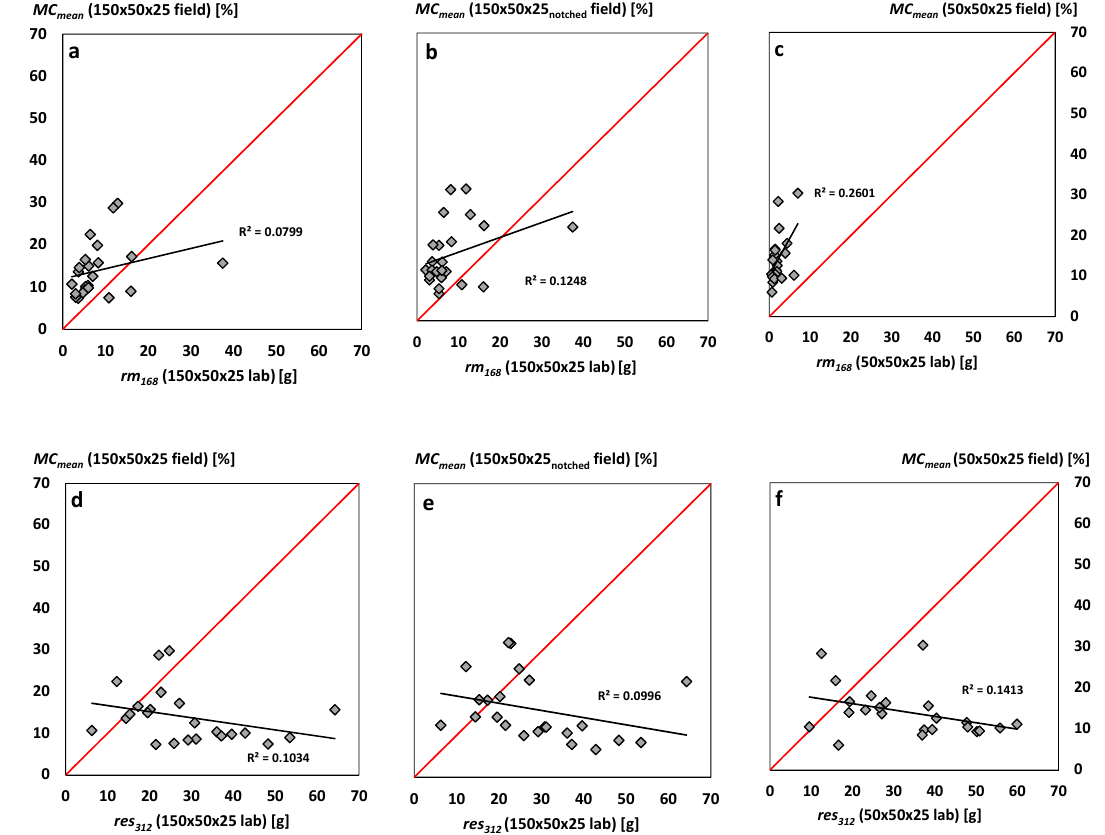
Figure 5. Interrelationship between MC mean (%) measured during outside exposure and rm 168 ( a – c ) and res 312 ( d – f ) in grams determined in submersion ( a , b , d , e ) and floating tests ( c , f ) according to [5].